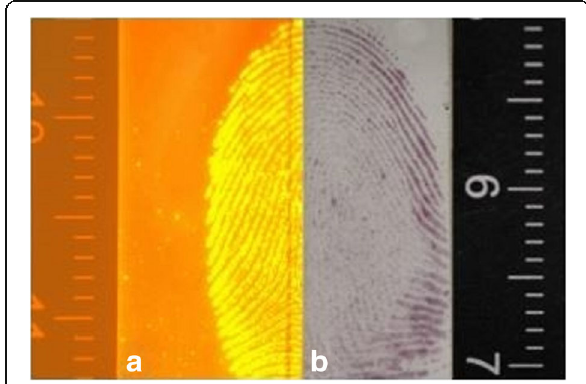
Fig. 7 Example of fingerpritns on thermal paper developed using a ) PVP/DFO with polilight lamp at 515nm excitation and b ) One step PVP/ninhydrin observed using white